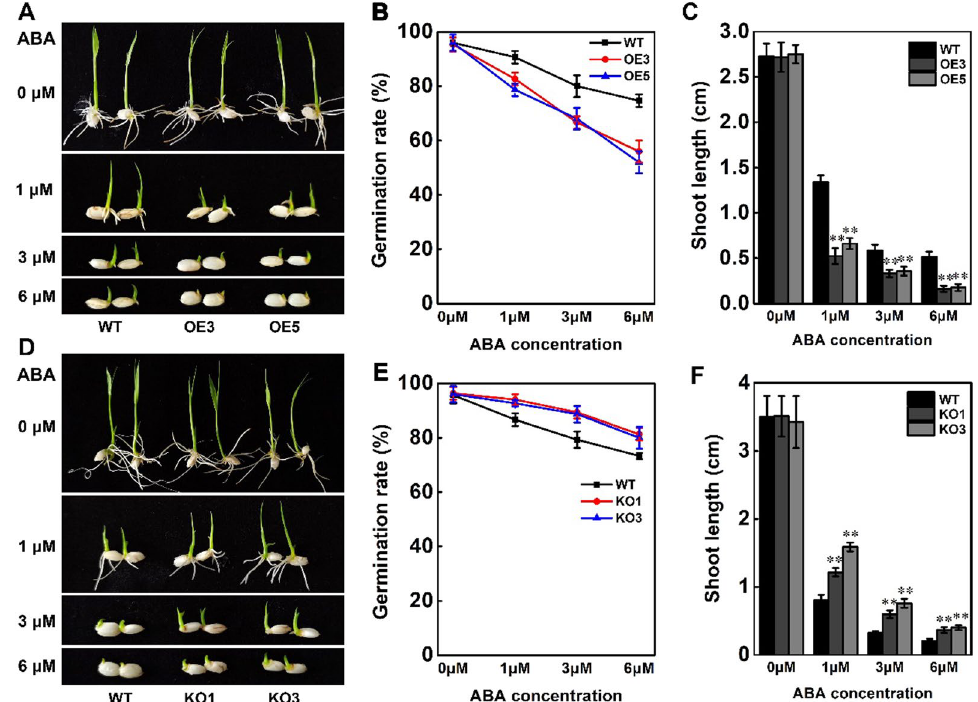
Fig. 5 Increased ABA sensitivity of STK overexpression plants at germination stage. A , D Germination performance of STK -OE ( A ) and STK -KO ( D ) seeds on 1/2MS medium containing 0, 1, 3, or 6 μM ABA at 5 d after initiation. B , E The germination rates of STK -OE ( B ) and STK -KO ( E ) seeds after 0, 1, 3, or 6 μM ABA treatment. C , F Shoot lengths of STK -OE ( C ) and STK -KO ( F ) plants after 0, 1, 3, or 6 μM ABA treatment for 5 d. Data in ( B , C , E , F ) are presented as mean SD (n 3, ** P 0.01, Tukey’s ± = ≤